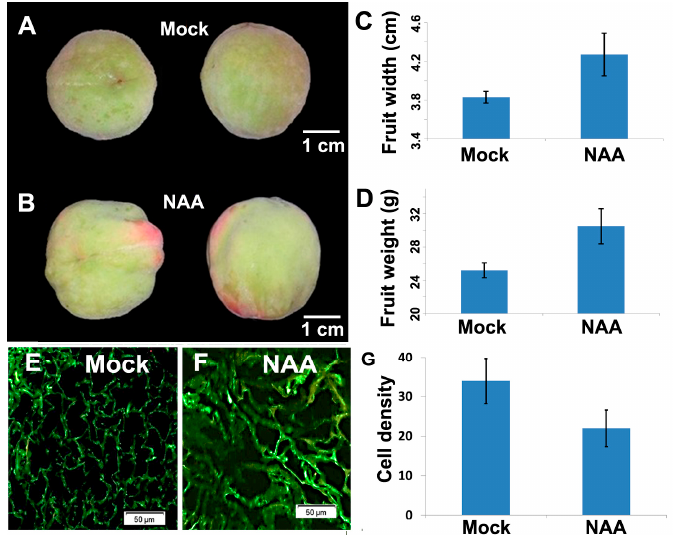
Figure 1. Auxin regulates fruit enlargement in peaches. The development of the peach fruit following a 3-day mock ( A ) and NAA treatment ( B ). Width ( C ) and weight ( D ) of the peach fruit under mock and NAA treatment. Bars indicate the standard variation of the values ( n = 30). Cross sections of mesocarp tissues derived from the fruit under 3-day mock ( E ) and NAA ( F ) treatments were shown in the representative 250- μ m wide × 250- μ m high regions; ( G ) cell densities were calculated by counting the number of the medium-sized cells regions in 250- μ m wide × 250- μ m high regions of cross section slides. Bars gives standard deviations ( n = 15). NAA, α -naphthylacetic acid.